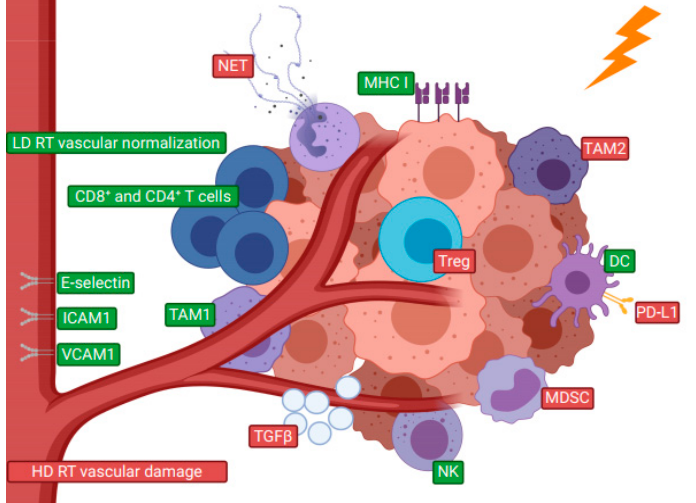
Figure 1. Selected immunomodulatory e ff ects of radiotherapy (RT) on tumor microenvironment (TME). Depending on the dose and fractionation as well as characteristics of established TME, RT can act immunostimulatory by enhancing major histocompatibility complex I (MHC I) expression, antitumoral type 1 tumor-associated macrophages (TAM1), natural killer cells (NK), dendritic cells (DC) and cytotoxic (CD8 + ) and helper (CD4 + ) T cell infiltration. Contrary, the RT impact can be immunosuppressive by inducing protumoral type 2 tumor-associated macrophages (TAM2), regulatory T cell (Treg) and myeloid-derived suppressive cell (MDSC) infiltration, programmed-death ligand 1 (PD-L1) upregulation, tumor growth factor β (TGF β ) expression, and neutrophil extracellular traps (NET) expulsion. The impact of low dose RT (LD RT) and high dose RT (HD RT) on tumor vasculature is di ff erential. Furthermore, RT induces adhesion molecules expression on endothelium, such as intercellular adhesion molecule 1 (ICAM-1), vascular cell adhesion molecule 1 (VCAM-1), and E-selectin, which are needed for leukocytes to extravasate and infiltrate tumors. (Created with